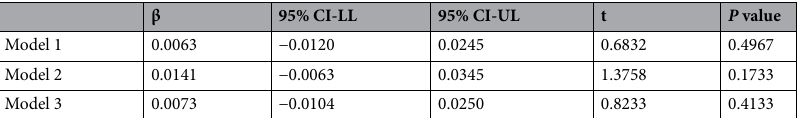
Table 3. Regression analysis between antibody-titers and the duration from vaccination to measurement. Model 1: Without adjustment. Model 2: Adjusted by age at the time of vaccination and sex. Model 3: Adjusted by BMI, the duration between transplantation and vaccination, eGFR, lymphocyte counts immediately prior to vaccination and Model 2. 95% CI ; confidence interval; LL lower limit. UL upper